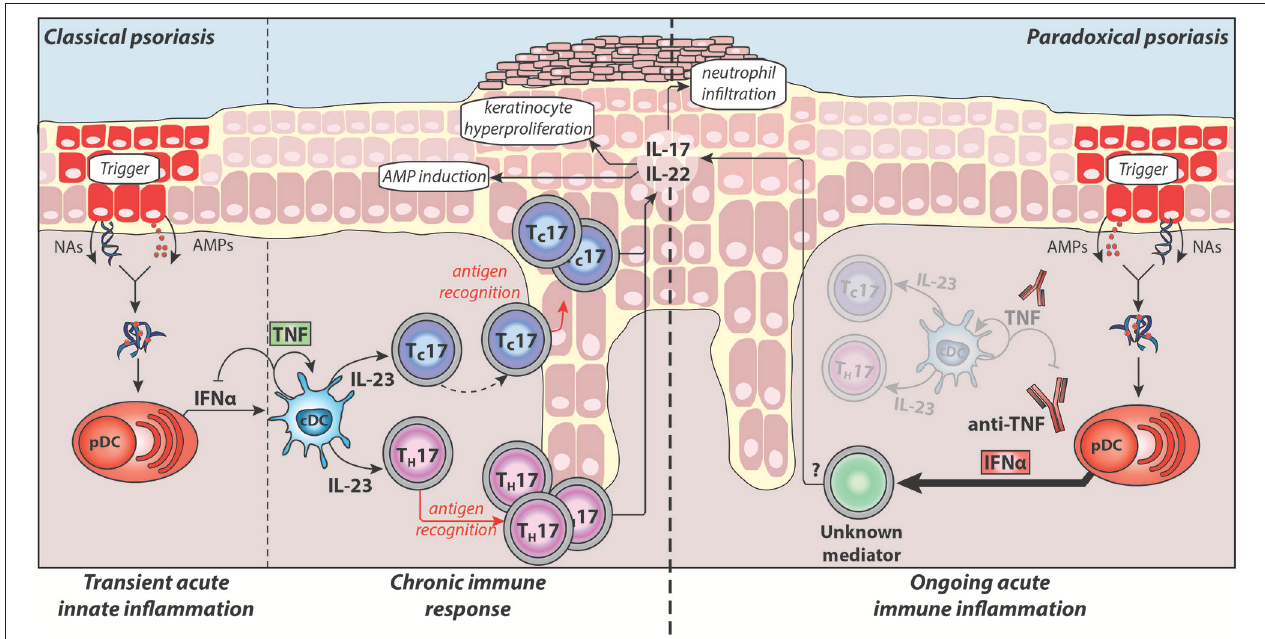
FIGURE 1 | Pathogenesis of classical plaque psoriasis and paradoxical psoriasis. Antimicrobial peptides (AMPs), which are produced by keratinocytes upon skin injury or released by neutrophils, form complexes with nucleic acids (NAs) released by dying cells. These complexes activate plasmacytoid dendritic cells (pDC) to produce large amounts IFN α during the acute/early phase of psoriasis pathogenesis. IFN α activates conventional dendritic cells (cDCs), which in turn produce TNF and IL-23. TNF induces the maturation of cDCs and pDCs, which lose their ability to produce IFN α . Thus, in classical psoriasis, early IFN α production gets relayed by TNF that controls and limits the IFN α production by pDCs via a negative feedback loop (through induction of pDC maturation). Subsequently, IL-23 and other pro-inflammatory cytokines produced by cDCs drive the activation of potentially autoreactive T-cells, which proliferate and, particularly CD8 + T C cells, migrate into